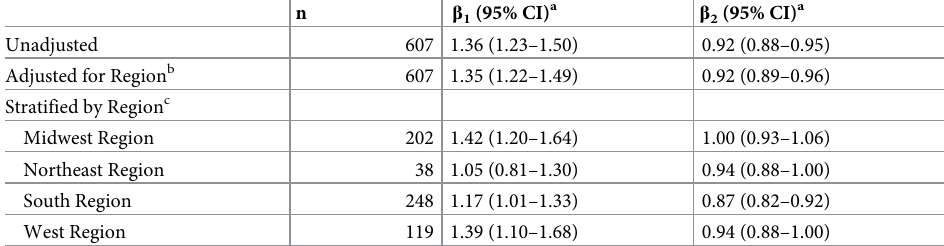
Table 1. Scaling coefficients from a piecewise linear